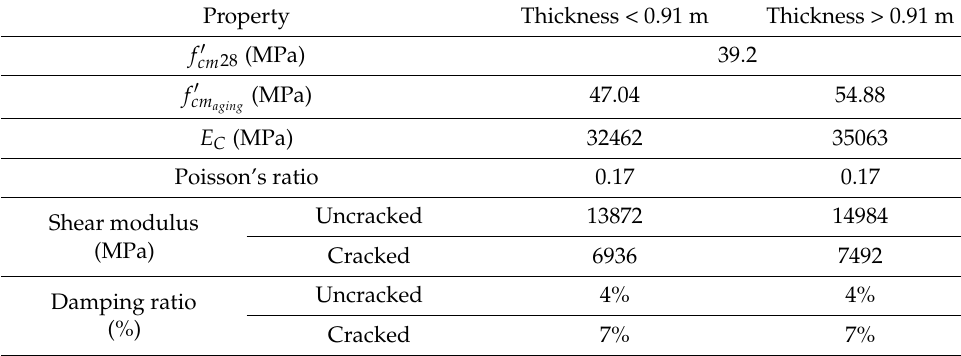
Table 1. Material properties of concrete.